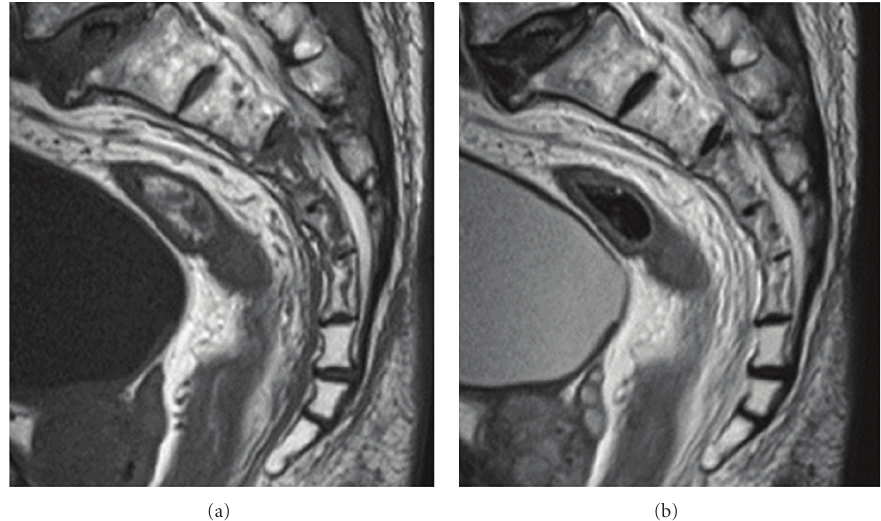
Figure 3: Preoperative magnetic resonance image. (a) Sagittal plane on a T1-weighted image and (b) sagittal plane on a T2-weighted image Third, fourth, and fifth sacral vertebral bodies showed low intensities on T1- and T2-weighted images.